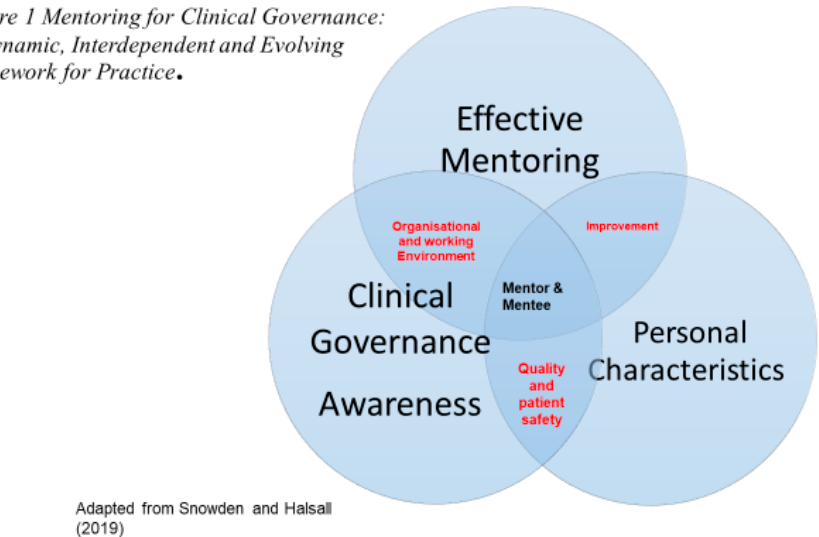
Figure 1. Reveals a new emerging framework termed “Mentoring for Clinical Governance: A Dynamic, Interdependent, and Evolving Framework for Practice”. This new framework facilitating mentorship was identified following a synthesis of all of the quantitative data.